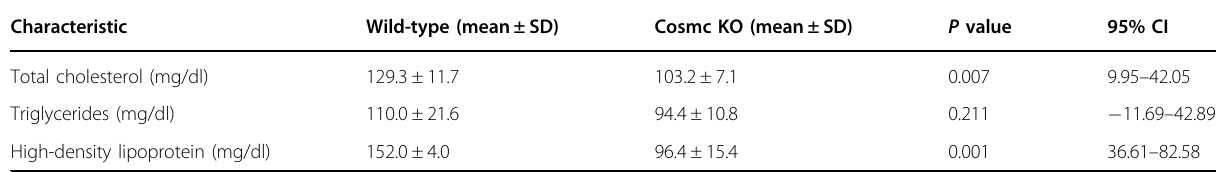
Table 2 Laboratory values of WT and Cosmc- KO mouse blood samples ( n = 5 each). Unpaired two-tailed Student ’ s t -test was used to test the level of signi fi cance